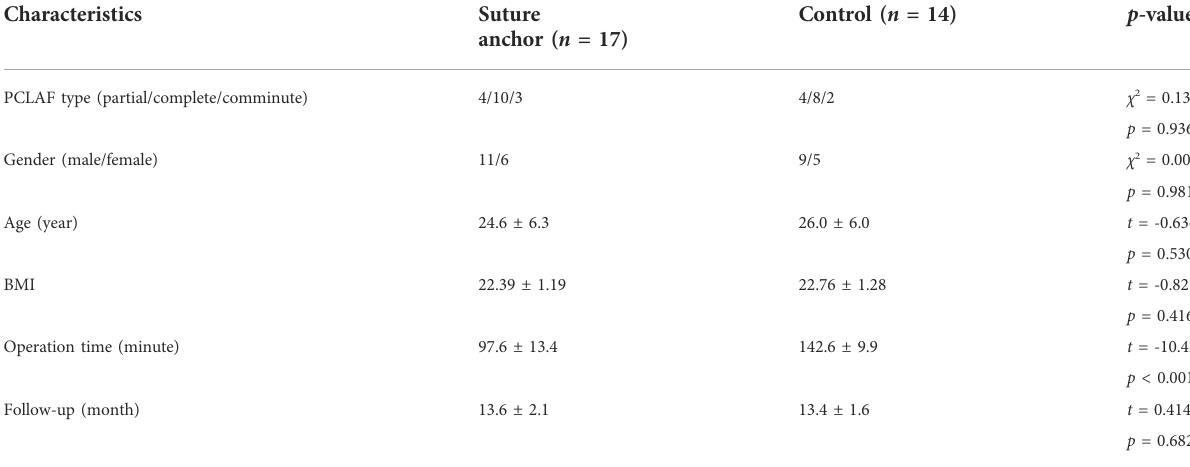
TABLE 1 Basic characteristics of PCLAF patients in the bio-absorbable suture anchor and control groups. Characteristics